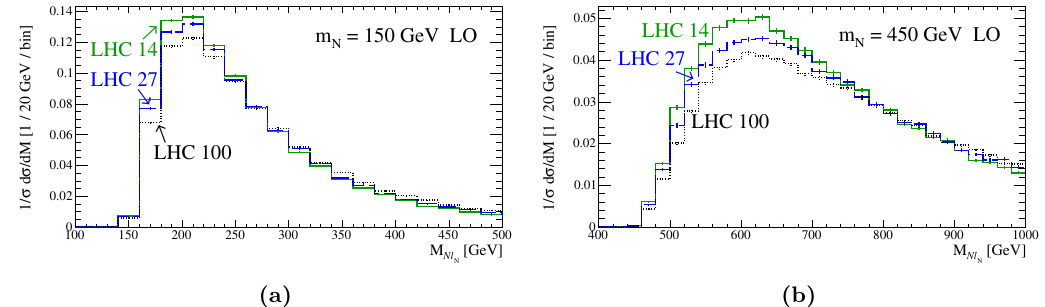
Figure 4. Normalized parton-level distribution for the invariant mass of the ( N‘ N ) system in the LO DY process pp Nl N Wl W l N (cid:23)l (cid:23) l W l N , at p s = 14, 27, and 100 TeV, assuming ! ! ! representative neutrino masses (a) m N = 150 GeV and (b) 450